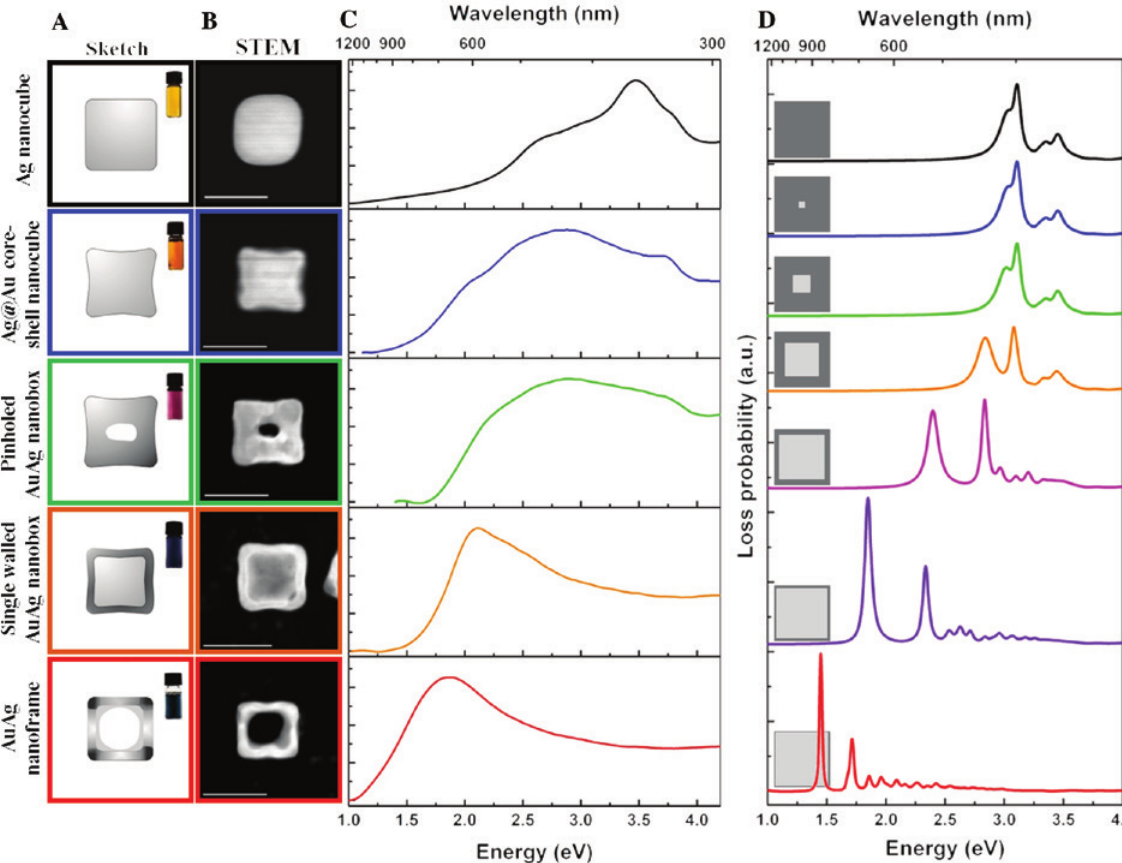
Figure 6: Structural and LSPR evolution of the AuAg nanostructures. (A) Structural sketches and corresponding solution colors from solid Ag nanocubes to single-walled AuAg nanobox and AuAg nanoframe. (B) HAADF STEM images of the nanostructures where SI EELS have been acquired (scale bars = 50 nm). (C) Zero-loss peak subtracted EEL spectra averaged over the areas of interests, i.e. EELS maps, showing the evolution of localized SPRs with structural changes. (D) BEM-simulated EEL spectra revealing the effect of void size for Ag nanostructures: 50 nm Ag nanocube (in black), 5 nm void (in blue), 15 nm void (in green), 30 nm void (in orange), 40 nm void (in magenta), 45 nm void (in purple), and 48 nm void (in red) (reproduced with permission from Ref. [133], copyright 2016 American Chemical